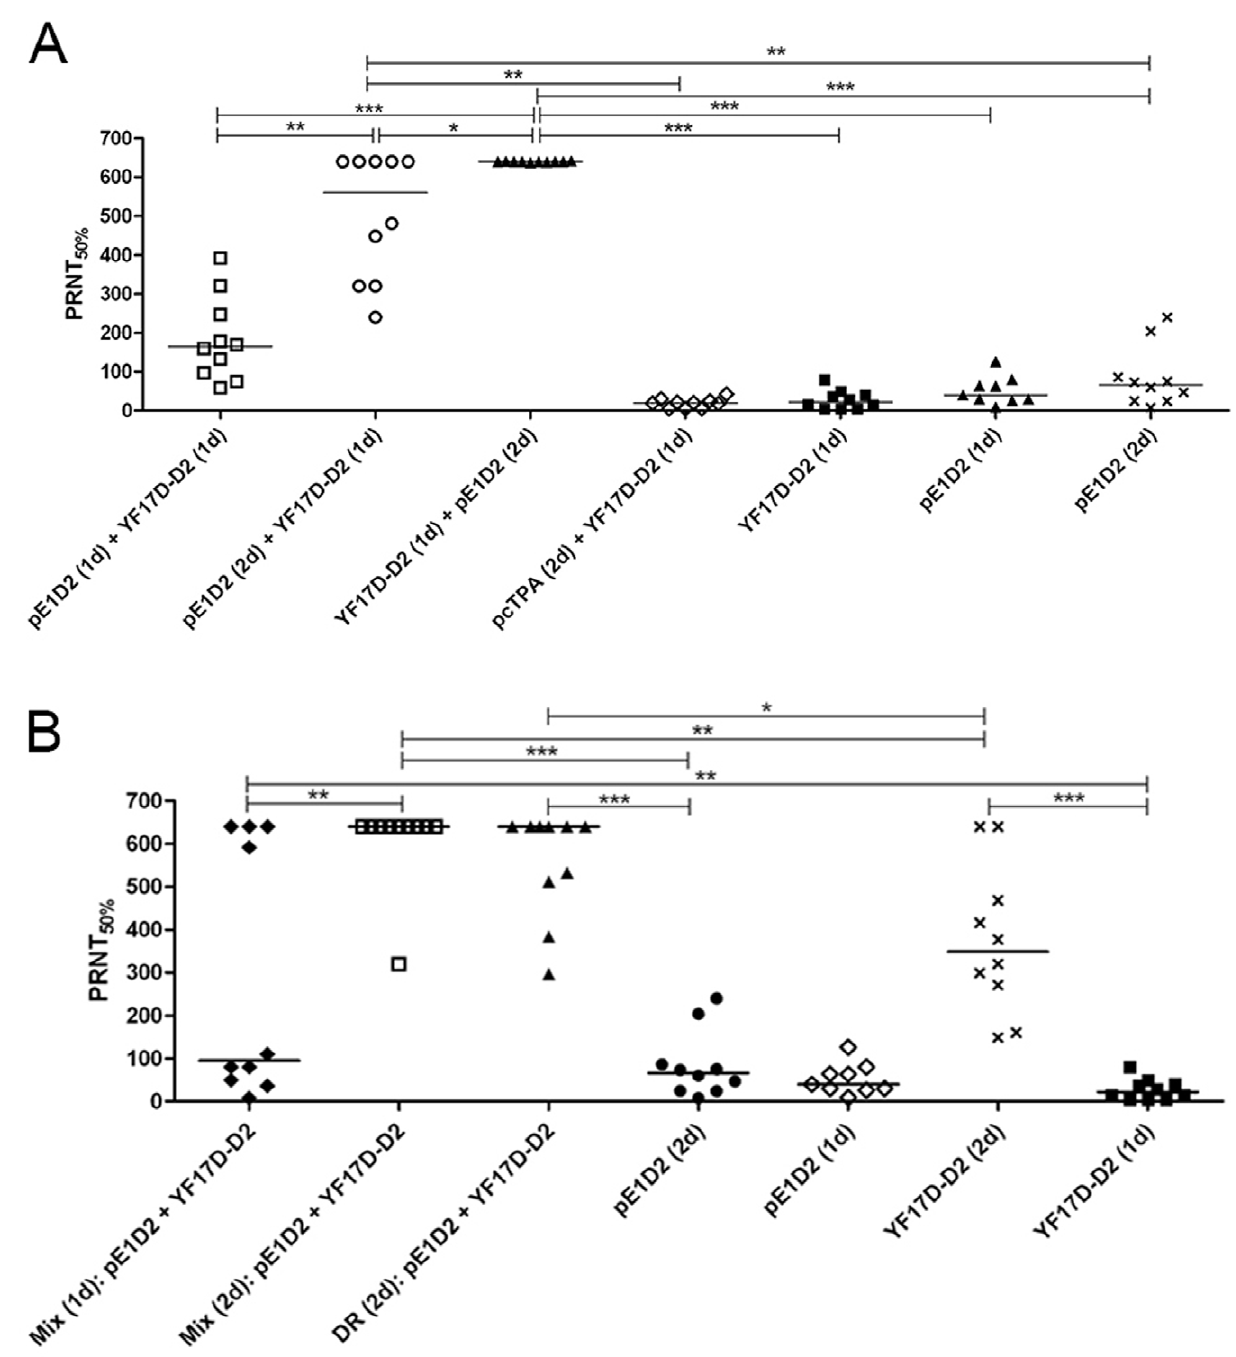
Figure 1. Neutralizing antibody responses against DENV2. Panels A and B refer to samples tested from animals immunized with prime-boost protocols or with simultaneous inoculations, respectively, and control groups. Individual serum samples were collected 24 h before virus challenge. Sera were serially diluted from 1:5 to 1:640 and the PRNT 50% was performed in 96-well plates. Asterisks indicate differences that are statistically significant using the Mann-Whitney test (*p , 0.05; **p , 0.01 and ***p , 0.001). One dose=1d; two doses=2d.